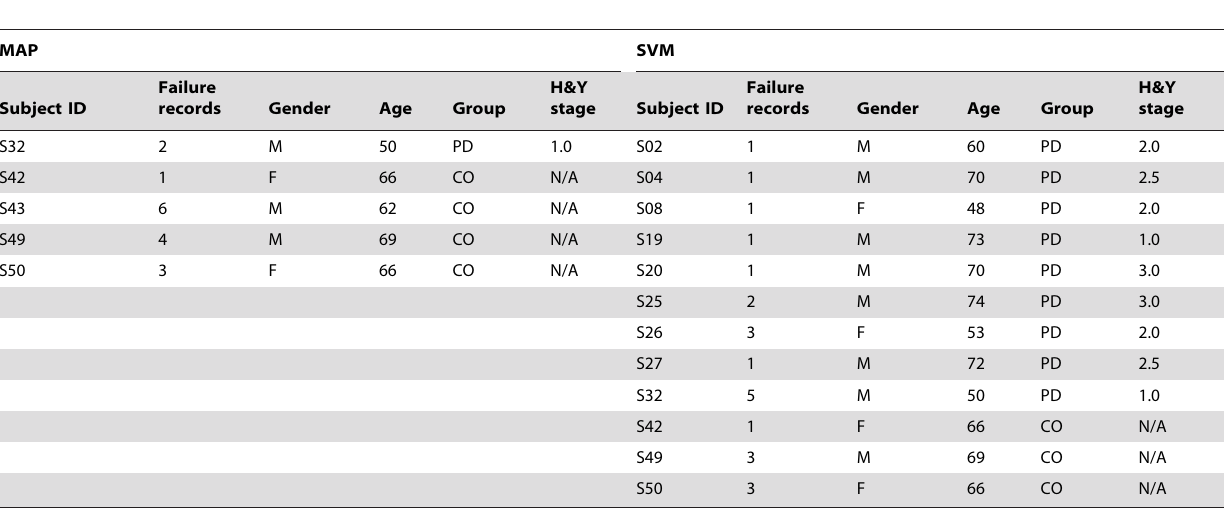
Table 2. Details of subject information on the records misclassified by the maximum a posteriori (MAP) and support vector machine (SVM)